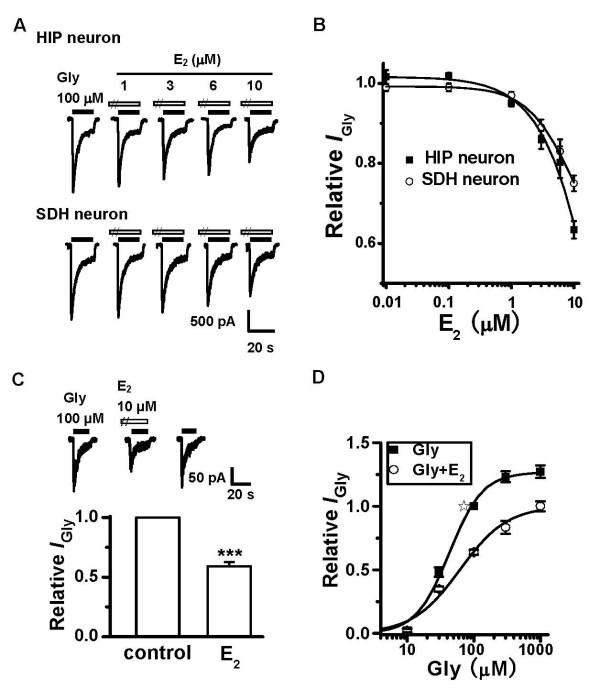
E2-induced inhibition of IGly in cultured SDH and HIP neurons. (A) Representative traces of current induced by 100 μM glycine in the presence or absence of E2 at various concentrations in cultured HIP (upper) and SDH (bottom) neurons. The neurons were pre-treated with E2 for 30 s before E2 and glycine were co-applied. (B) Summarized data illustrating the concentration dependence of E2 inhibition (n = 4–8) as shown in A. (C) E2 significantly inhibited IGly recorded from the outside-out patches (n = 5). The upper traces show the representative IGly recorded from outside-out patches in the presence and absence of E2. ***P < 0.001, Paired Student's t-test, compared with control without adding E2. (D) The concentration-response curves of IGly in the presence and absence of 10 μM E2. For each neuron recorded, the current was normalized to the peak amplitude of IGly induced by 100 μM glycine alone (✰) from the same neuron and each point represents the average value of 5–9 neurons.